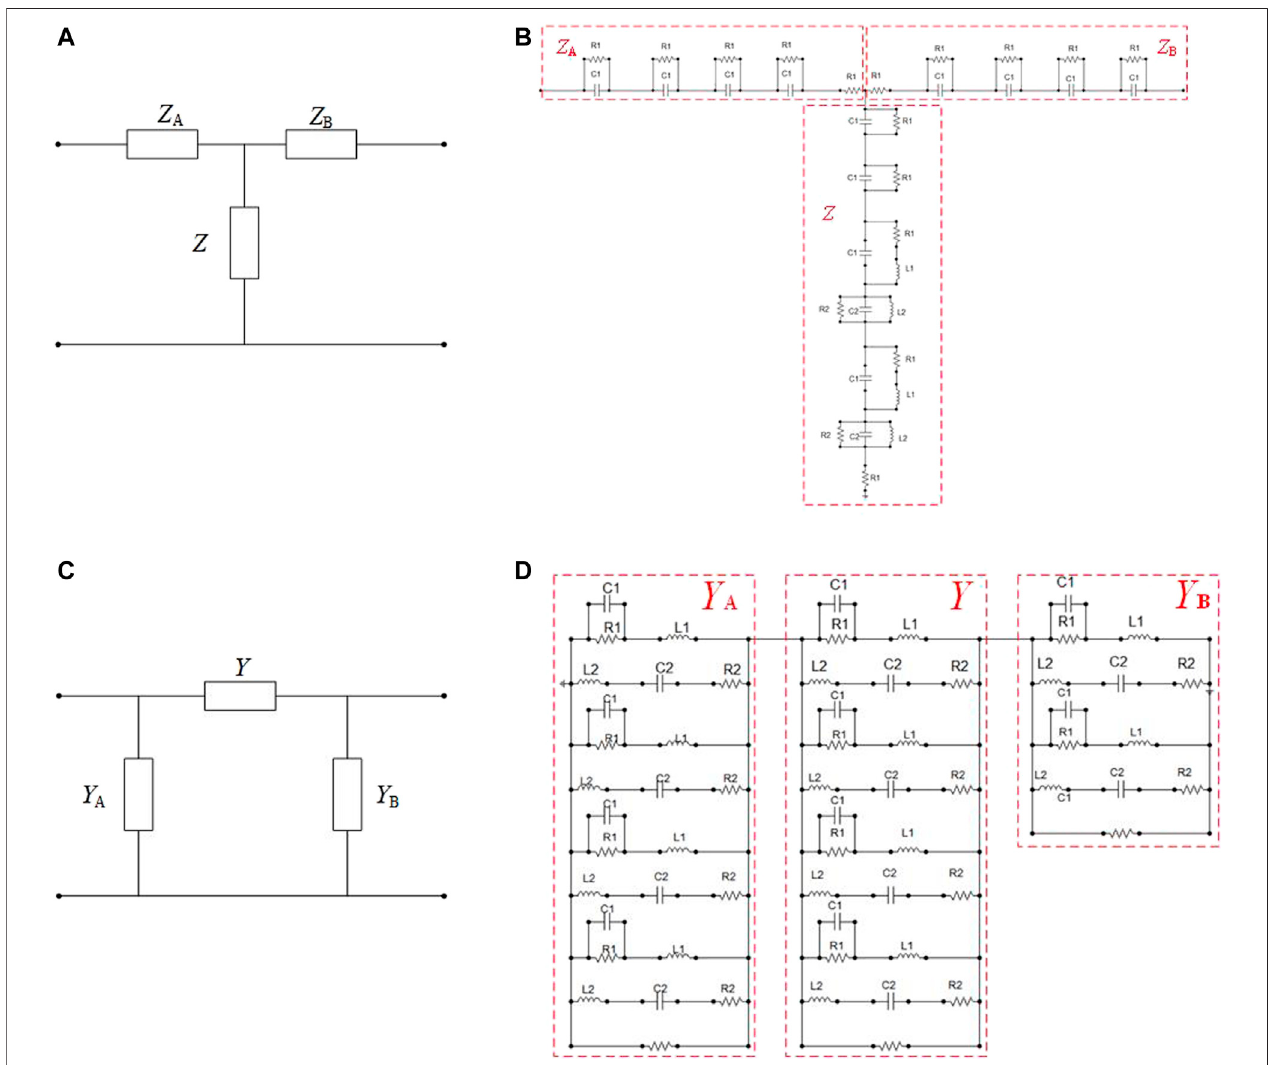
FIGURE 4 | Two port equivalent circuit. (A) T-shaped two port equivalent circuit; (B) The broadband equivalent circuit model of grounding grid; (C) π -shaped network of potential transformer. (D) The broadband equivalent circuit model of potential transformer.